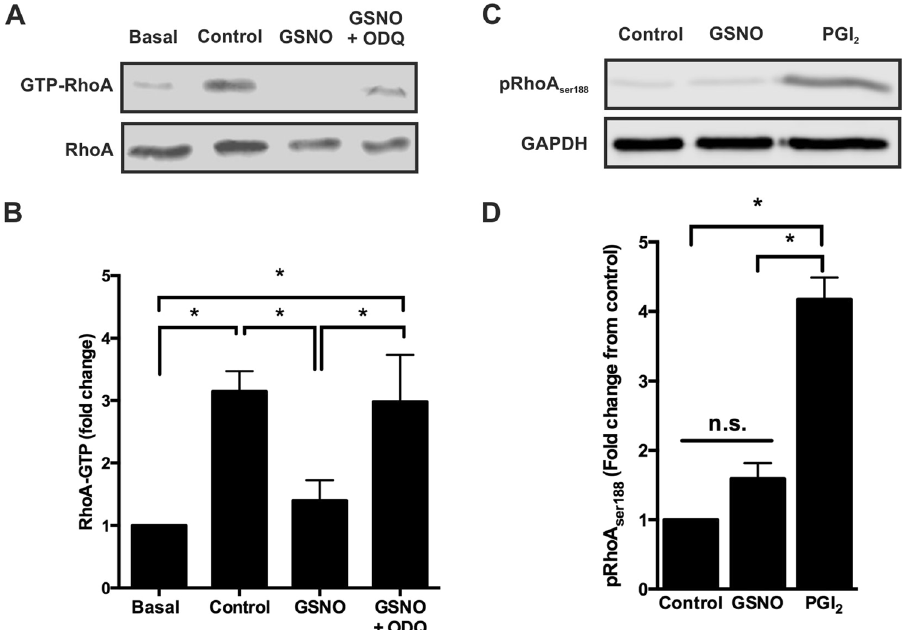
Figure 4. PKG activation upon exposure of spread platelet to NO leads to inhibition of RhoA via a pRhoA ser188 independent mechanism. Platelets (2 × 10 8 /ml) were allowed to spread on fibrinogen-coated (100 µ g/mL) 10 cm dishes for 25 minutes prior to treatment. Adhered platelets were then lysed for either analysis of RhoA activation status or in laemmli buffer and blotted for pRhoA ser188 and GAPDH as a loading control. ( A ) Cropped gel image for the detection of GTP-bound (active) RhoA in basal, control spread platelets, and spread platelets in response to GSNO (1 µ M) ± ODQ (2 µ M) for 20 minutes is representative of at least 3 experiments (full length gel represented in Supplementary Figure S6). ( B ) Relative density of GTP-bound RhoA in each condition. ( C ) Cropped gel image for the detection of phosphorylated RhoA ser188 in control and in response to GSNO (1 µ M) and PGI 2 (10 nM) for 20 minutes is representative of at least 3 experiments (full length gel represented in Supplementary Figure S8) ( D ) Relative density of pRhoA ser188 in each condition. Images are representative of at least 3 individual experiments. Error bars represent S.E.M. with significance ( * ) defined as p <